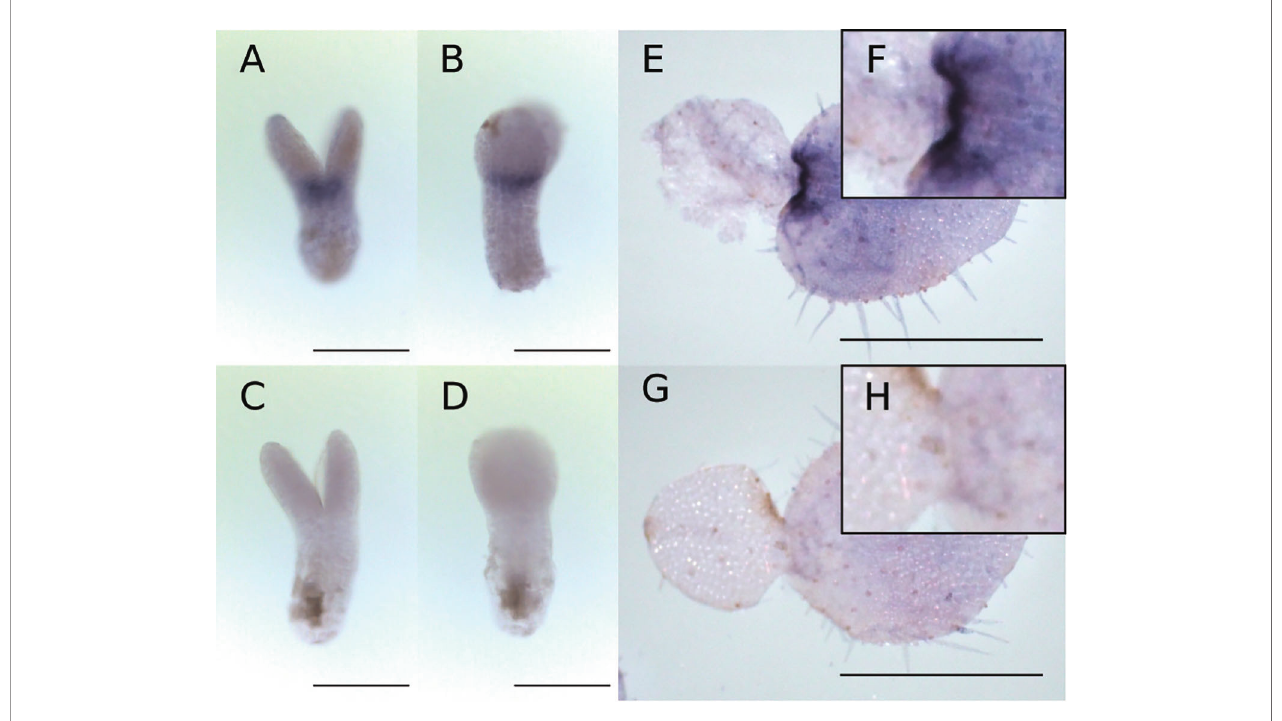
FIGURE 6 | WMISH of Mg-AN3 at the at the isocotyledonous stage (8 DAS) (A – D) and anisocotyledonous stage (17 DAS) (E – H) . (A, B, E, F) Antisense probe. (C, D, G, H) Sense probe. (A, C) Frontal view. (B, D) Side view. (F) Magni fi ed image of the GM in (E) . (H) Magni fi ed image of the GM in (G) . Bar = 200 µm in (A – D) , 1 mm in (E, G)